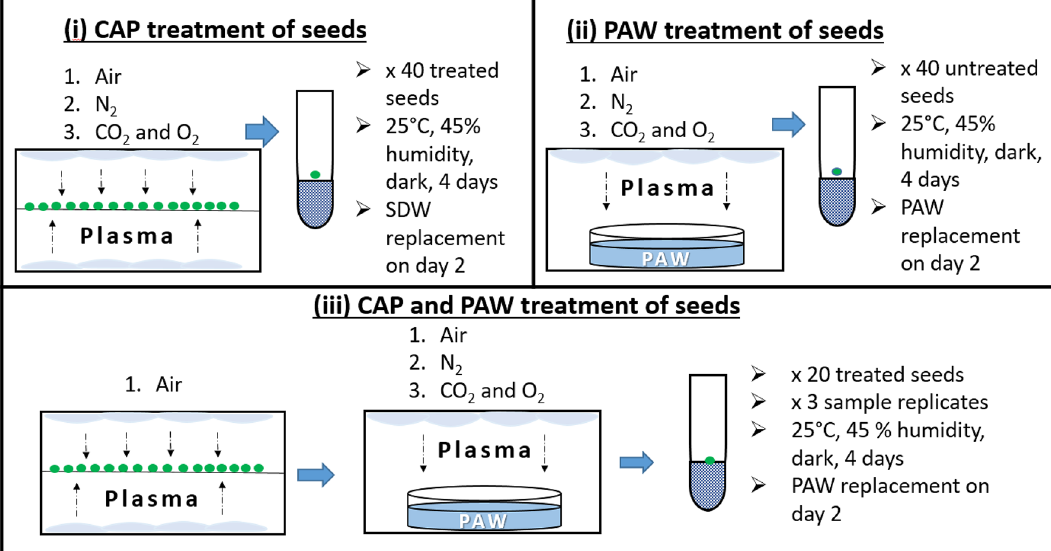
Figure 7. Summary of plasma parameters and experimental method adopted for assessing mung bean seed germination and growth following ( i ) CAP treatment of seeds, ( ii ) PAW treatment of seeds and ( iii ) combined CAP and PAW treatment of